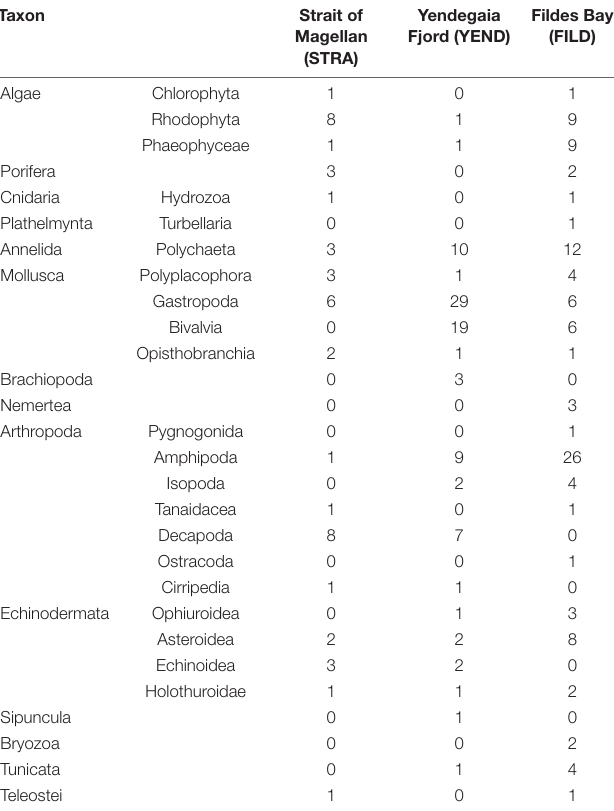
TABLE 3 | Summary of species identified in this study. Normalised stochasticity ratio reached average values above 50% in the three localities ( Figure 5 and Supplementary Table 3 Taxon Strait of Magellan